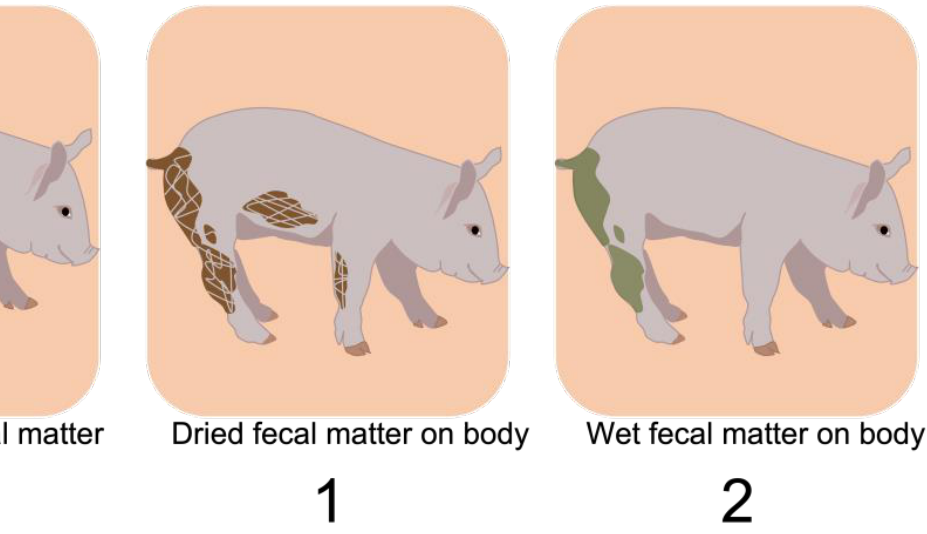
Figure 4. Human data- Hide score used by observers to classify pigs according to their clinical signs. In addition, emesis events were recorded. Humans collected data for each pig in a pen, while standing in front of the pen for 3 min.